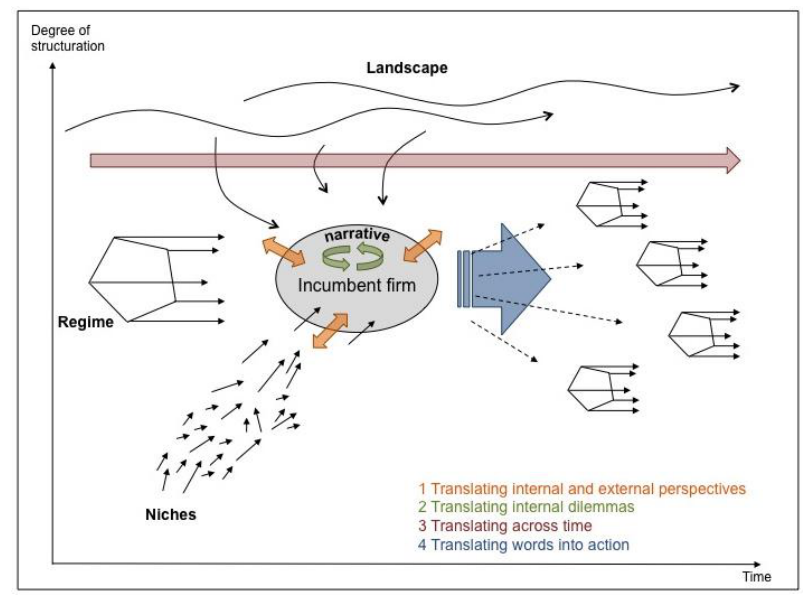
Figure 1. Corporate narratives as an approach of dealing with the “transition dilemma” (based on [53] (p. 25): A Multi-Level Perspective on Transitions).